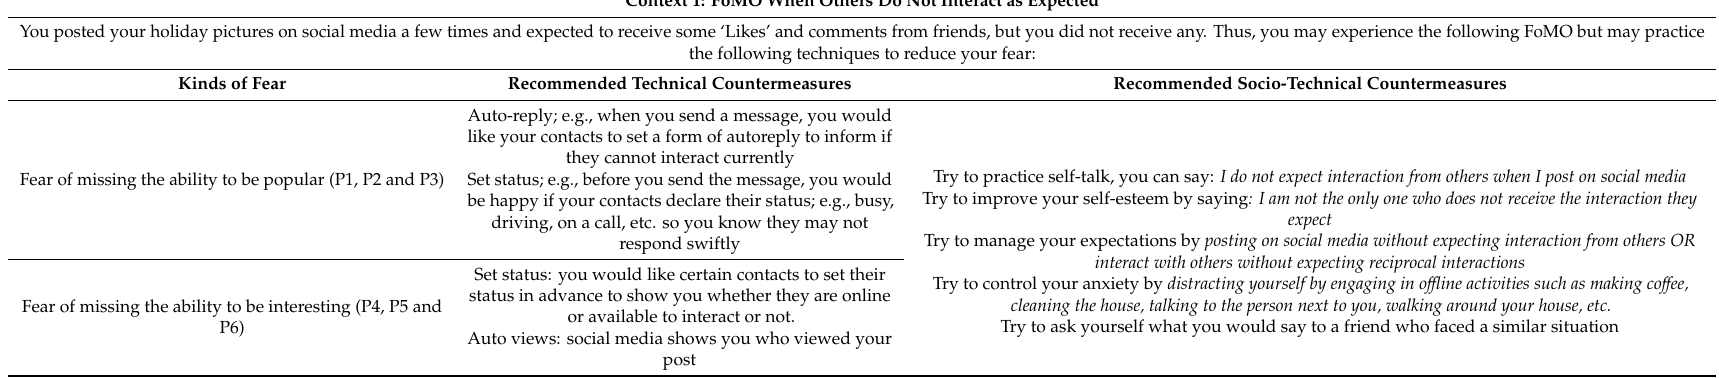
Table 5. Sample of relapse prevention (Booklet 3 in the Supplementary